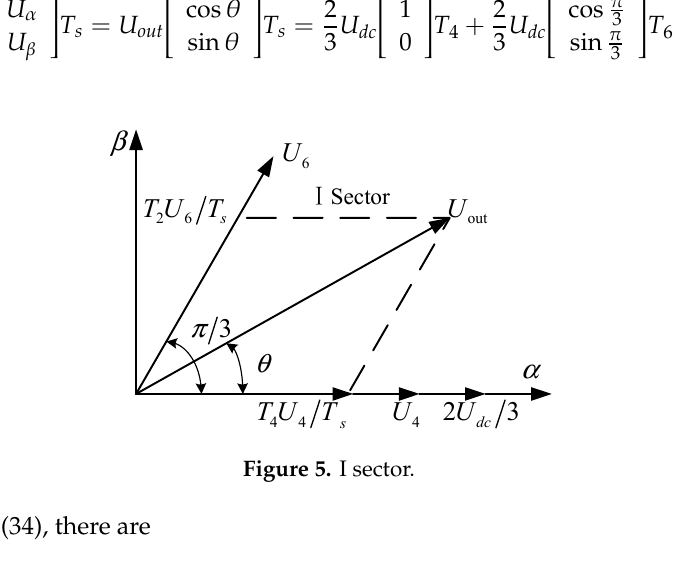
Figure 5. I sector. Figure 5. I